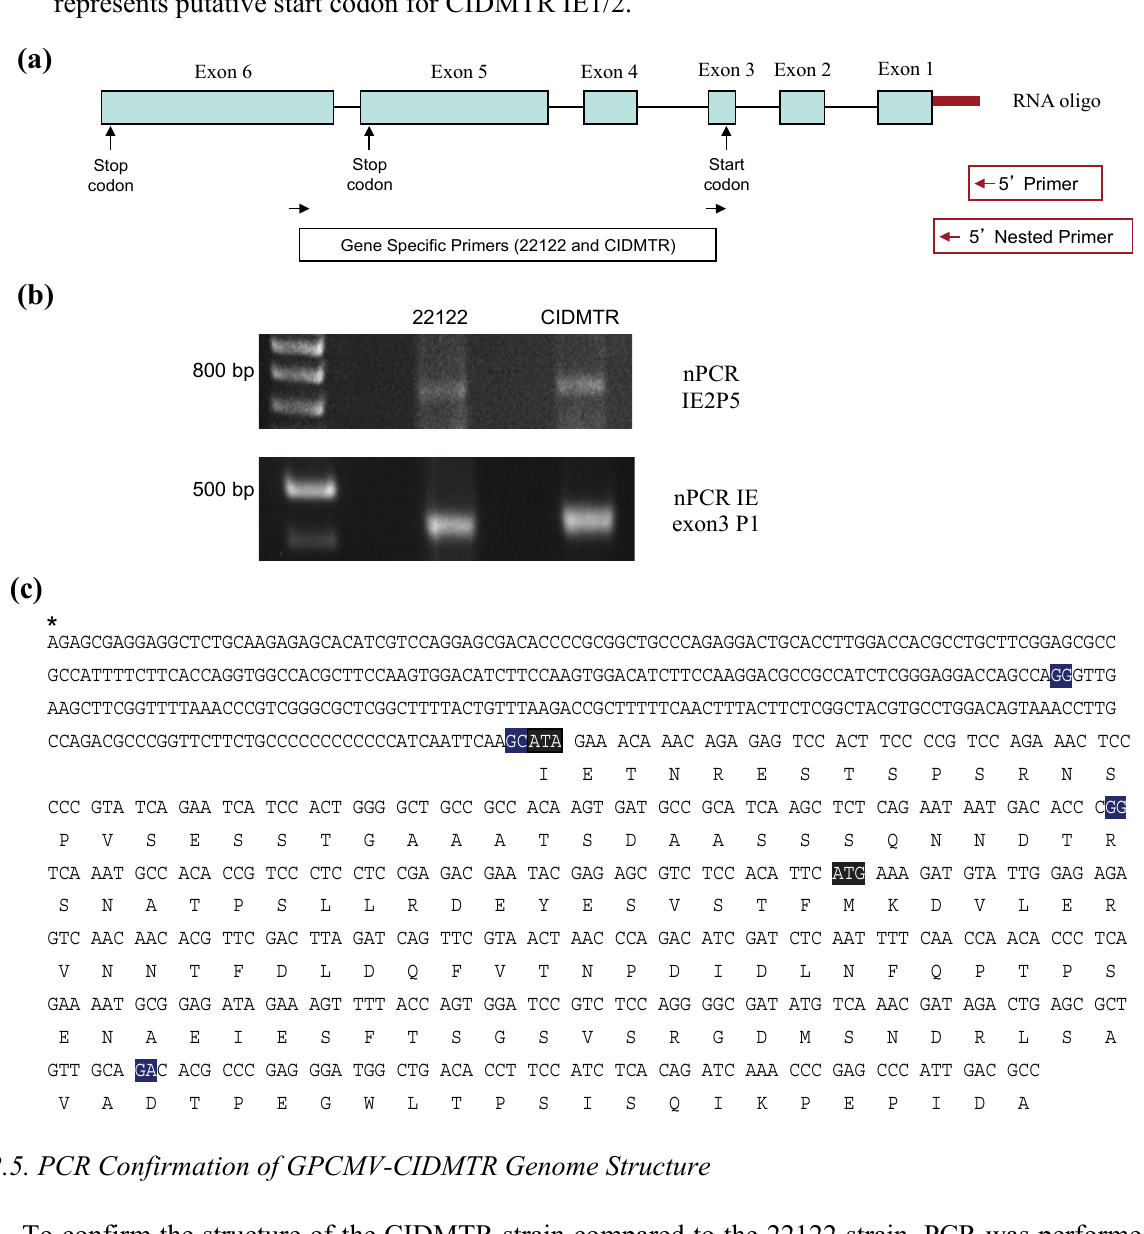
To confirm the structure of the CIDMTR strain compared to the 22122 strain, PCR was performed on viral DNA from both strains, using primers spanning the mismatched regions observed in the sequence analysis comparisons (Figure 3b, boxed/shaded regions). Two primers pairs were used for each region of mismatch (mismatch region 1 and mismatch region 2). PCR was performed using primer pairs mismatch-region 1 F1/R1 and mismatch-region 1 F2/R2, that amplify a ~4-kb region